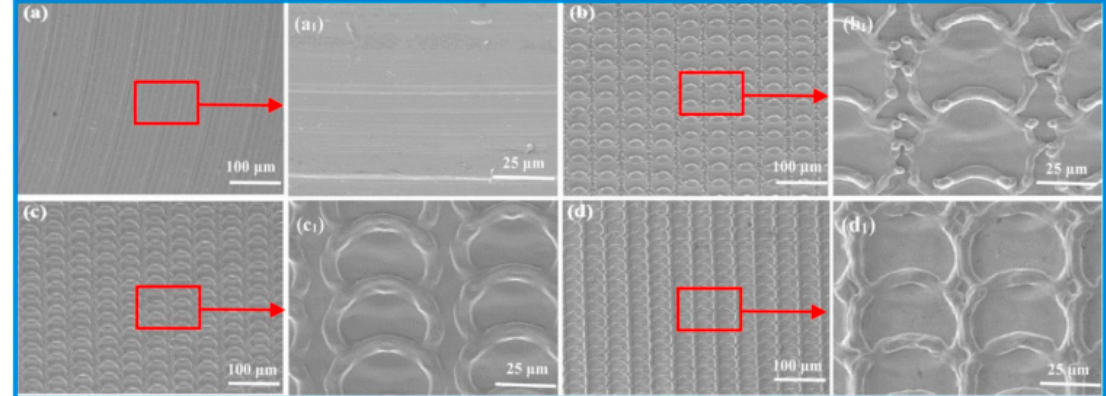
Figure 3. SEM images of the un-textured and textured surfaces: ( a , a 1 ) untextured surface, ( b , b 1 ) micro-bulge ring arrays ( c , c 1 ) micro-smooth ring arrays, and ( d , d 1 ) micro smooth stacked ring [53]. Reprinted from [53]. Copyright from Elsevier 2020.